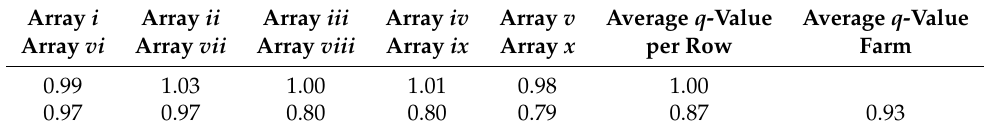
Table 10. WEC farm q -values for the 50 WEC farm for an irregular wave of H m 0 = 1.80 m